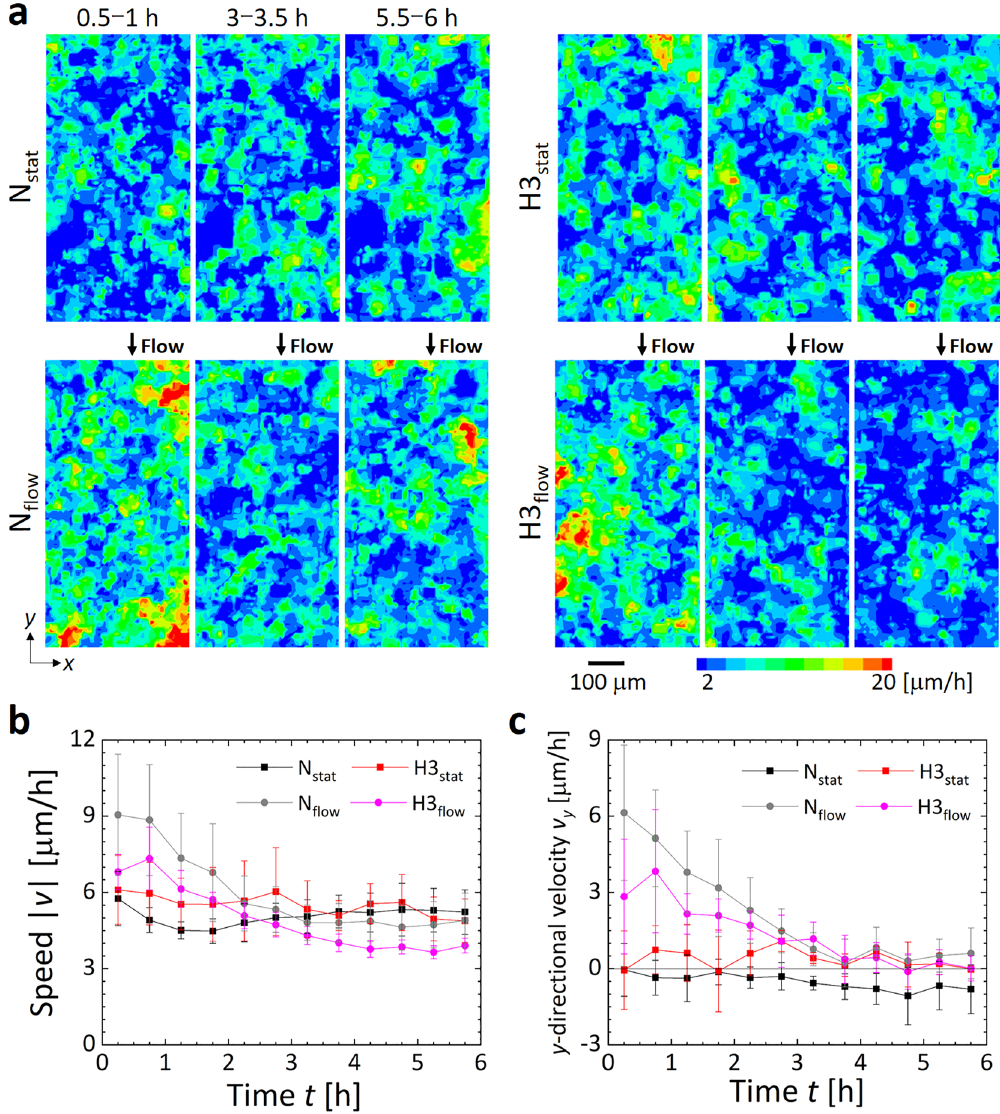
Figure 4. Collective migration of ECs in the monolayer under the four different oxygen and flow conditions N stat , H3 stat , N flow , and H3 flow . When the flow is present, it is applied in the - y -direction. ( a ) Contour maps of migration speed | v | obtained by PIV analysis using sequential phase-contrast microscopic images at 30 min intervals. Velocity vectors are shown in supplemental materials (Supplementary Figs. S4–S7). ( b ) Time variations of the spatially averaged migration speed | v | and the y -directional velocity v y of ECs during a 6-h measurement period while exposing the cells to the oxygen and flow conditions. Error bars show the standard